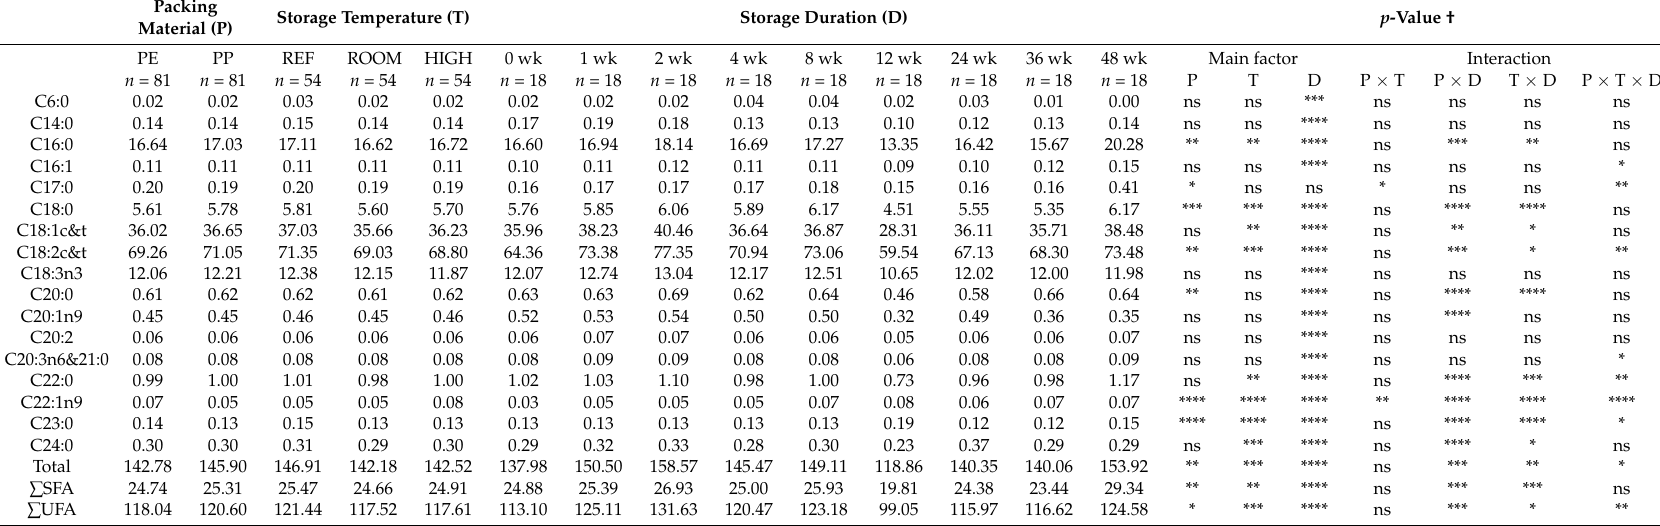
Table 1. Comparison of raw soybean flour fatty-acid composition and content (mg · g − 1 ) based on packaging material, storage temperature, storage duration, and the associated ANOVA p -values for the main factors and their